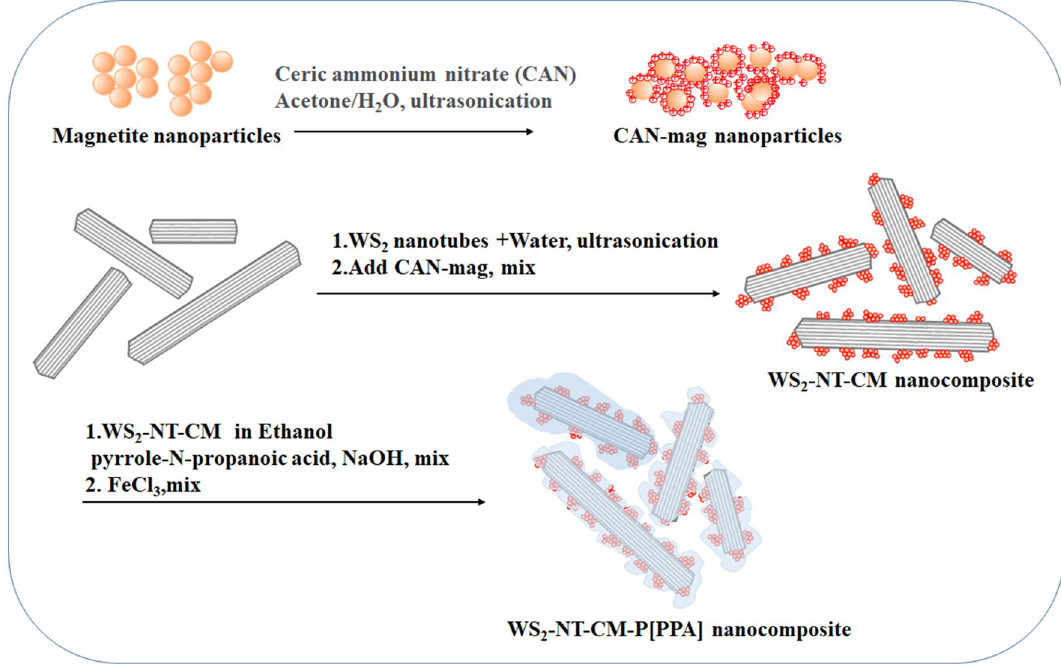
Figure 1. Schematic description of WS 2 -NT-CM-P[PPA] nanocomposite